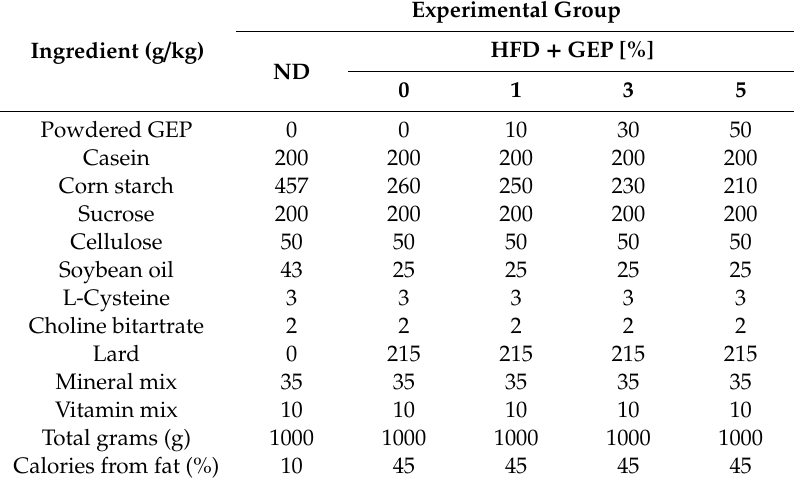
Table 2. Dietary compositions used in this